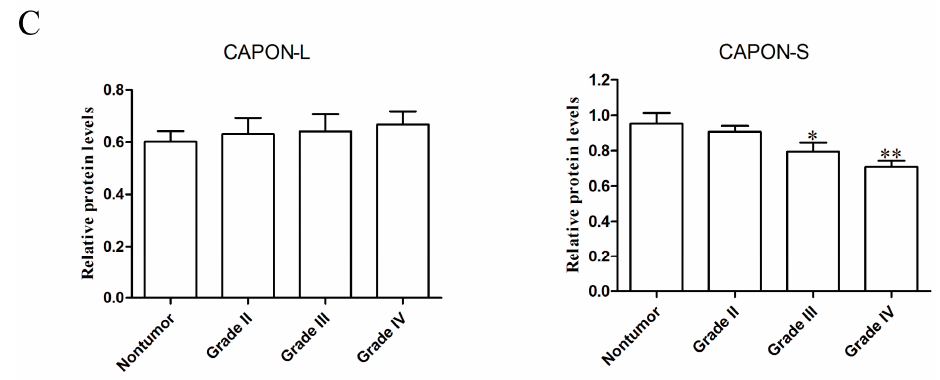
Figure 1. Changes in the expression levels of CAPON in nontumorous and glioma tissues. ( A ) Quantitative real-time PCR was used to measure the mRNA levels of CAPON in nontumor brain tissues ( n = 8) and various grades of glioma tissues ( n = 8 for each grade); ( B , C ) Western blot was used to measure the protein levels of CAPON in nontumor brain tissues ( n = 9) and different grades of glioma tissues (Grade II, n =12; Grade III, n = 12; Grade IV, n = 9). Representative blot pictures are shown in B and quantitative graphs for relative CAPON-L and CAPON-S protein levels are shown in C (* p < 0.05; ** p < 0.01).